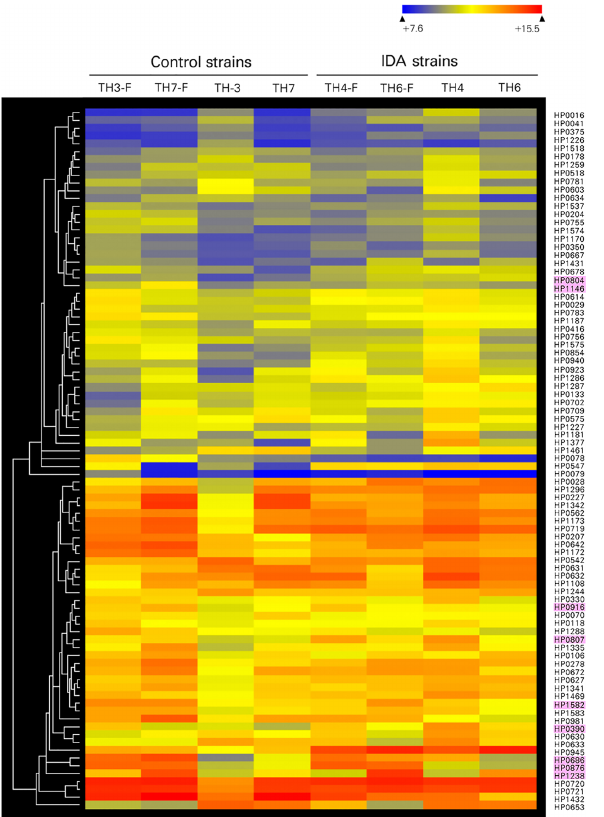
Fig 2. Hierarchical cluster analysis of gene expression alteration of control H . pylori strains under iron-replete and limited conditions. Each strain was culturedwith DFM (iron-limited condition,indicatedas TH3-F, TH7-F, TH4-F, and TH6-F) or without DFM (iron-replete condition,indicatedas TH3, TH7, TH4, and TH6). The geneswith significantdifferences in expressionwere includedin hierarchical clustering analysis using averagelinkageand Euclidean dissimilarity methods. Genes with a Fur-binding site consensus sequenceare indicatedin